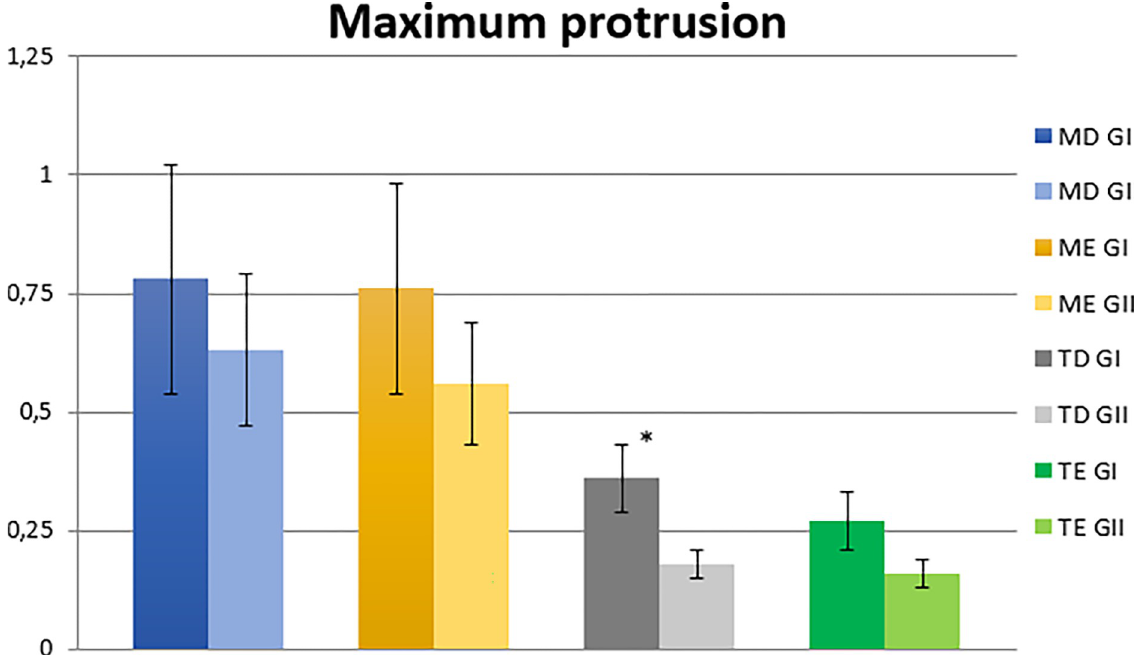
Fig 3. Normalized electromyographic means (RMS) in the maximum protrusion condition for the right masseter (RM), left masseter (LM), right temporal (RT) and left temporal (LT) muscles, in the MIH (MIHG) and control (CG) groups. MIH, Molar-incisor